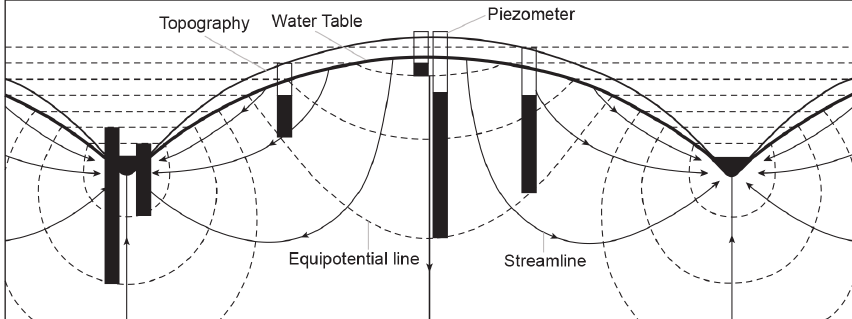
Figure 6. The flow net of groundwater flow between two rivers obtained by Hubbert (1940) and the head in selected piezometers (modified from Fetter, 1994).